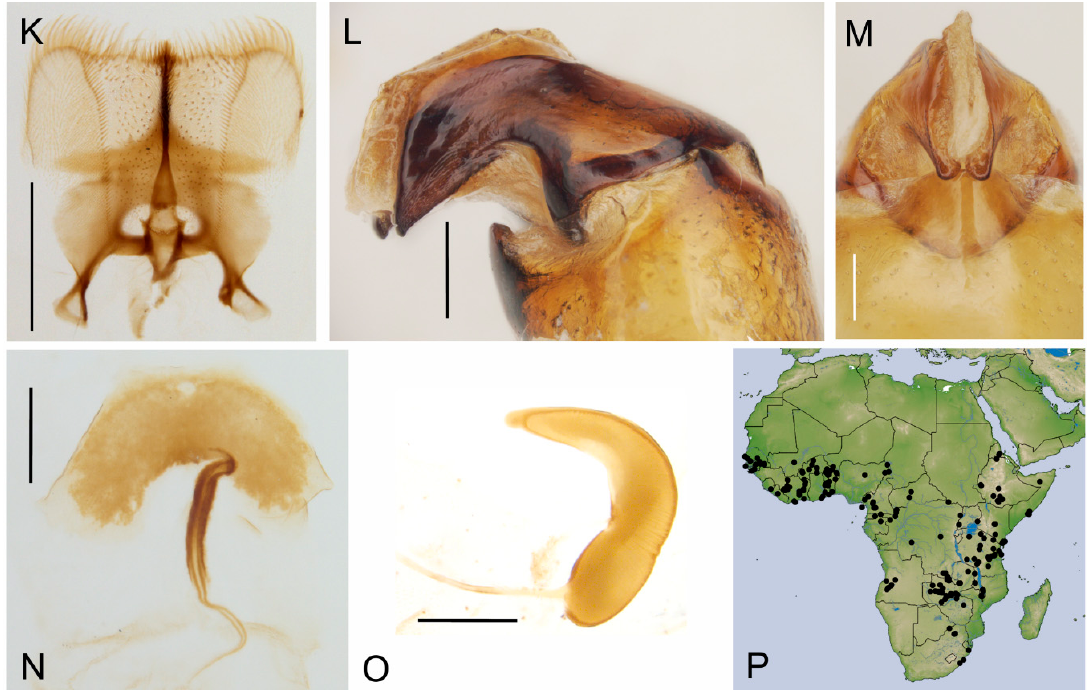
Figure 6. Unique combination of features characterizing Tiaronthophagus n.gen. ( A ): T. naevius , pronotum (from above): the thick pubescence on the surface and basal glabrous oval area are clearly evident, scalebar = 1 mm. ( B ): T. aequatus , pronotum puncture on disc, scalebar = 1 mm. ( C ): T. ebenus , head with few large setigerous points on the genae and near the genal sutura, scalebar = 0.1 mm. ( D ): T. naevius , pronotum side view, with the glabrous oval area, the corresponding concave area on elytra near the humeral callus (white arrow), and the row of points on the pronotum margin (black arrow), scalebar = 1.0 mm. ( E ): T. chrysoderus , elytral stria with the geminate points, scalebar = 0.2 mm. ( F ): T. rolandoi , eye with the basal triangular expansion, scalebar = 0.3 mm. ( G ): T. rufostillans , female head, vertex lamina, scalebar = 1.0 mm. ( H ): T. pseudoliberianus , female side view of the head and pronotum, highlighting the head carinae and the pronotum tubercles, scalebar = 2.0 mm. ( I ): T. macroliberianus , major male head, vertex lamina, scalebar = 2.0 mm. ( J ): T. ebenus , major male head, vertex lamina, scalebar = 1.0 mm. ( K ): T. ebenus , epipharynx, scalebar = 0.5 mm. ( L ): T. zambesianus , parameres side view, scalebar = 0.2 mm. ( M ): T. aequatus , apices of parameres, and phallobase distal margin, front view, scalebar = 0.2 mm. ( N ): T. rufobasalis , vagina infundibular tube, scalebar = 0.2 mm. ( O ): T. zavattarii , receptaculum seminis, scalebar = 0.2 mm. ( P ): Map of distribution of Tiaronthophagus